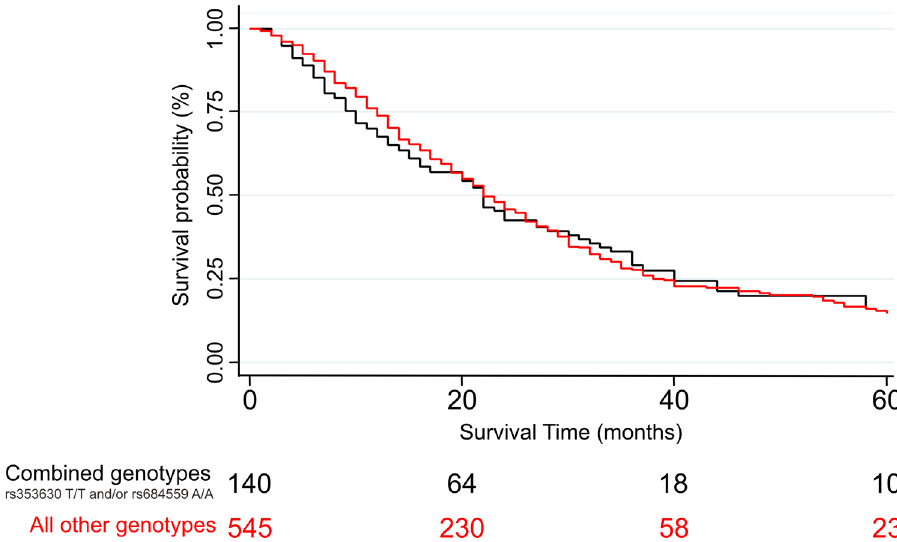
Figure 1. Kaplan–Meier curve showing the survival of resected PDAC patients diagnosed in stage I or II, according to the combined genotypes of CD44-rs353630 and